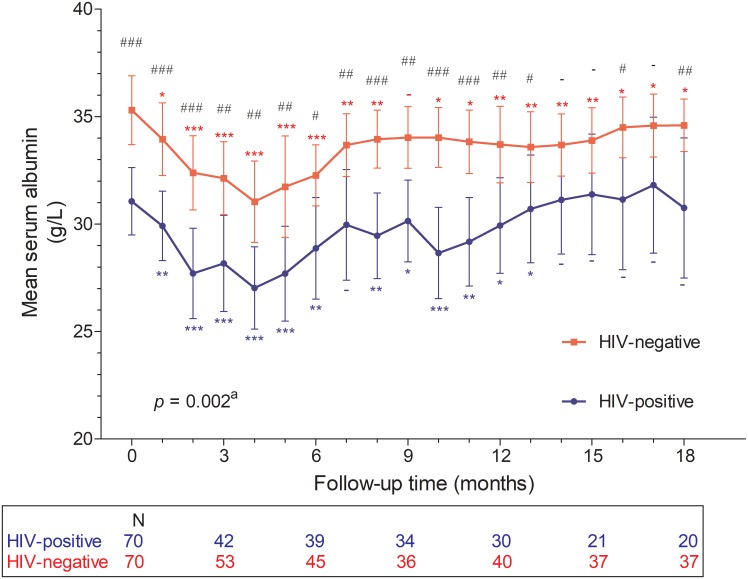
Monthly mean serum albumin with confidence intervals according to HIV-status.HIV, human immunodeficiency virus aTwo-factor analysis of variance for repeated measurements comparing monthly mean serum albumin over 18 months according to HIV status # independent t-test comparison of monthly mean serum albumin between the HIV-negative and HIV-positive cohorts p<0.05 (##, p<0.01; ###, p<0.001; -, p>0.05) * paired t-test comparison of means between baseline and follow-up monthly serum albumin p<0.05 (**, p<0.01; ***, p<0.001; -, p>0.05) N, number of study patients who presented and were sampled at specified clinic visit.